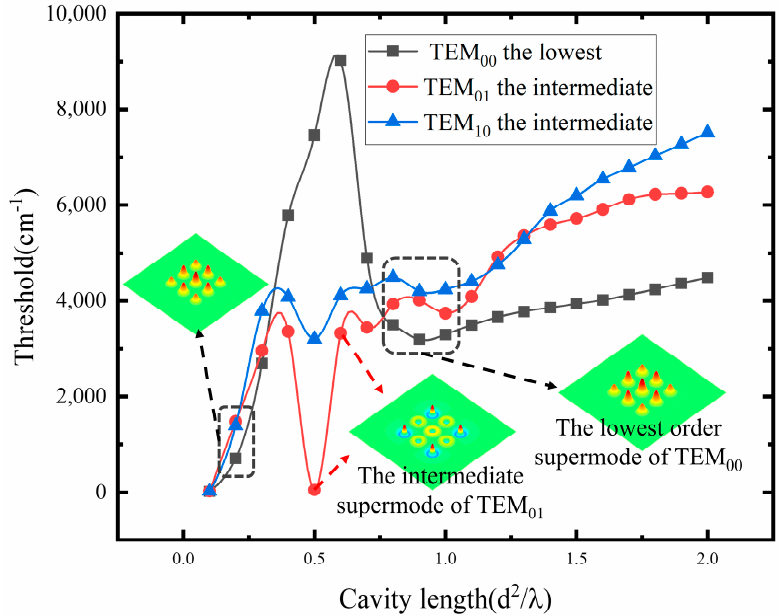
Figure 4. The thresholds of supermodes generated by the TEM 01 and TEM 10 high-order transverse mode element arrays and the thresholds of the supermode with the lowest mode square array generated by the TEM 00 transverse mode versus the length of external cavity from 0.1 − 2.0 d 2 / λ .